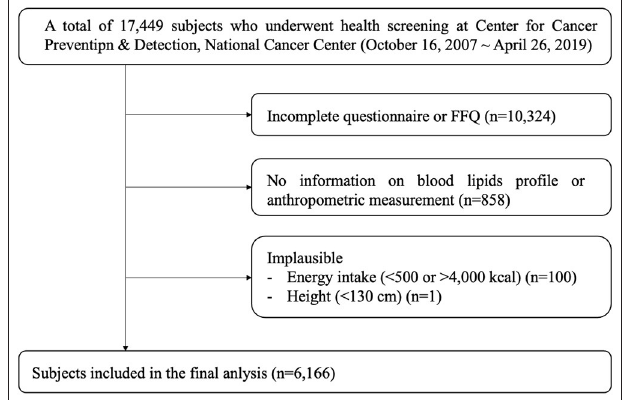
FIGURE 1 | Flow chart of the participant selection